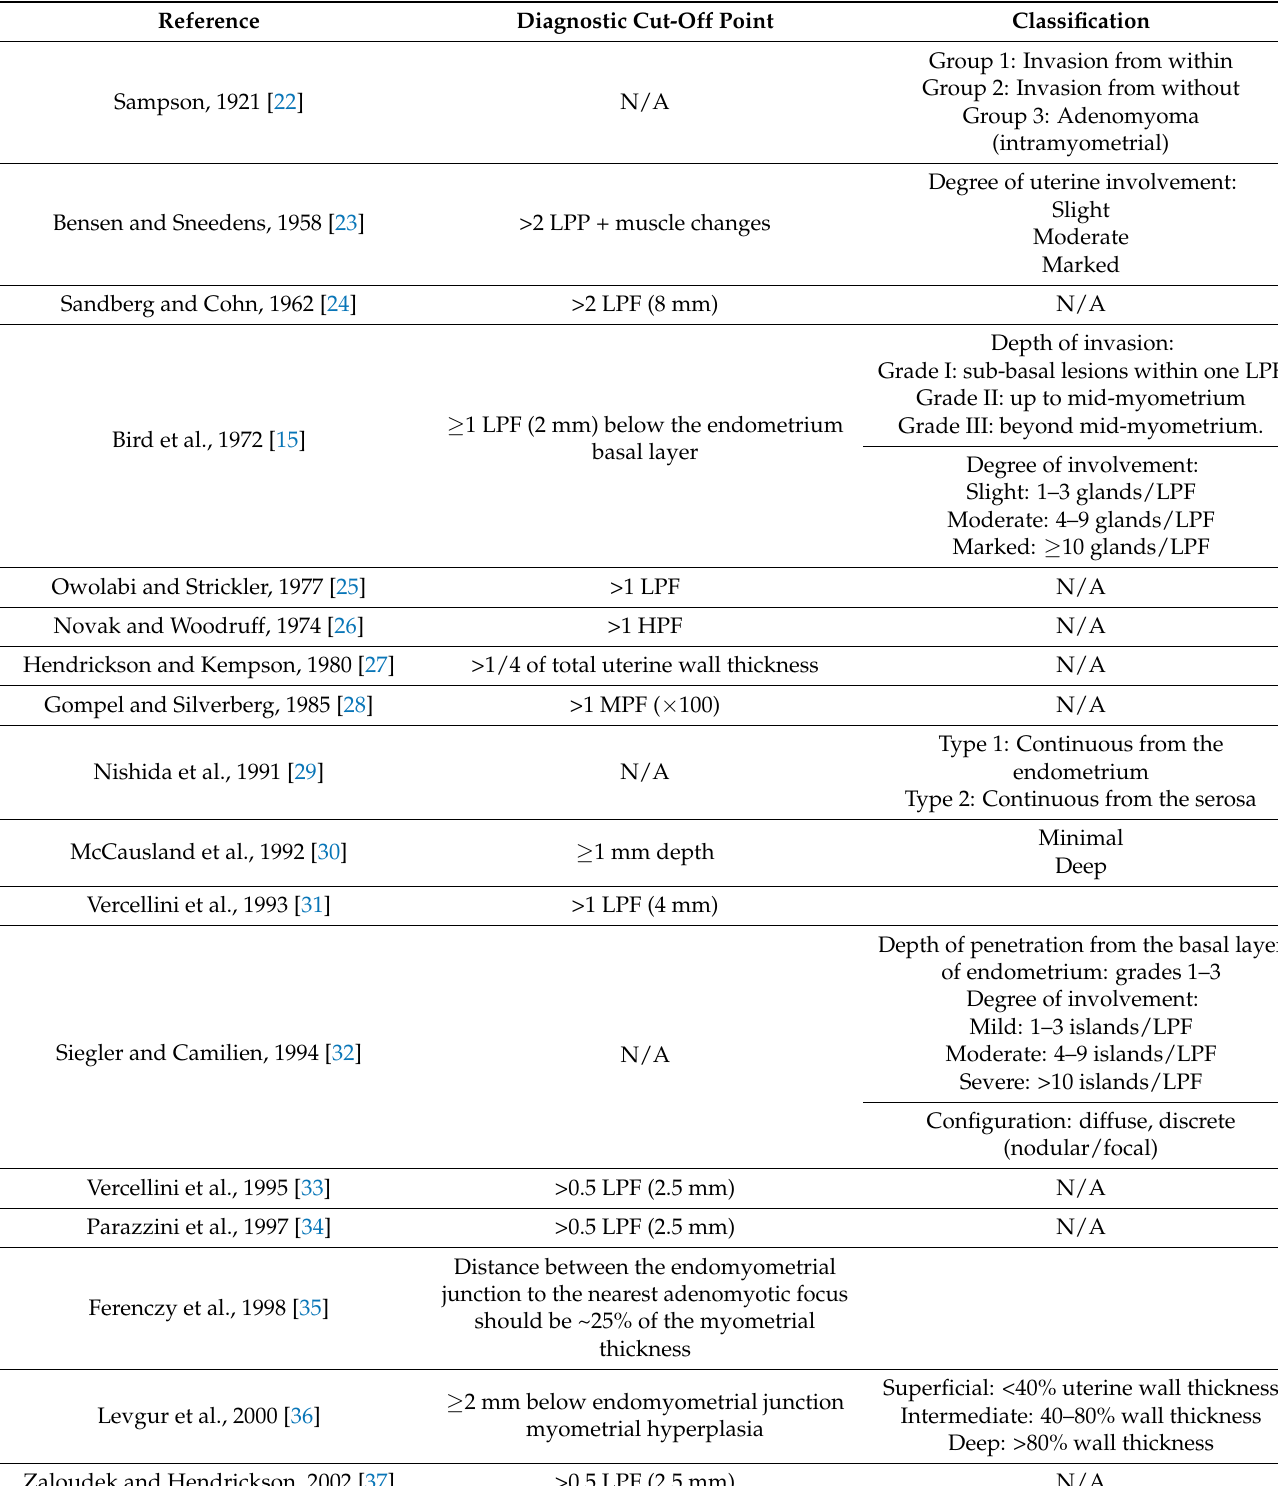
Table 1. Histological diagnostic criteria and based classification of adenomyosis in different